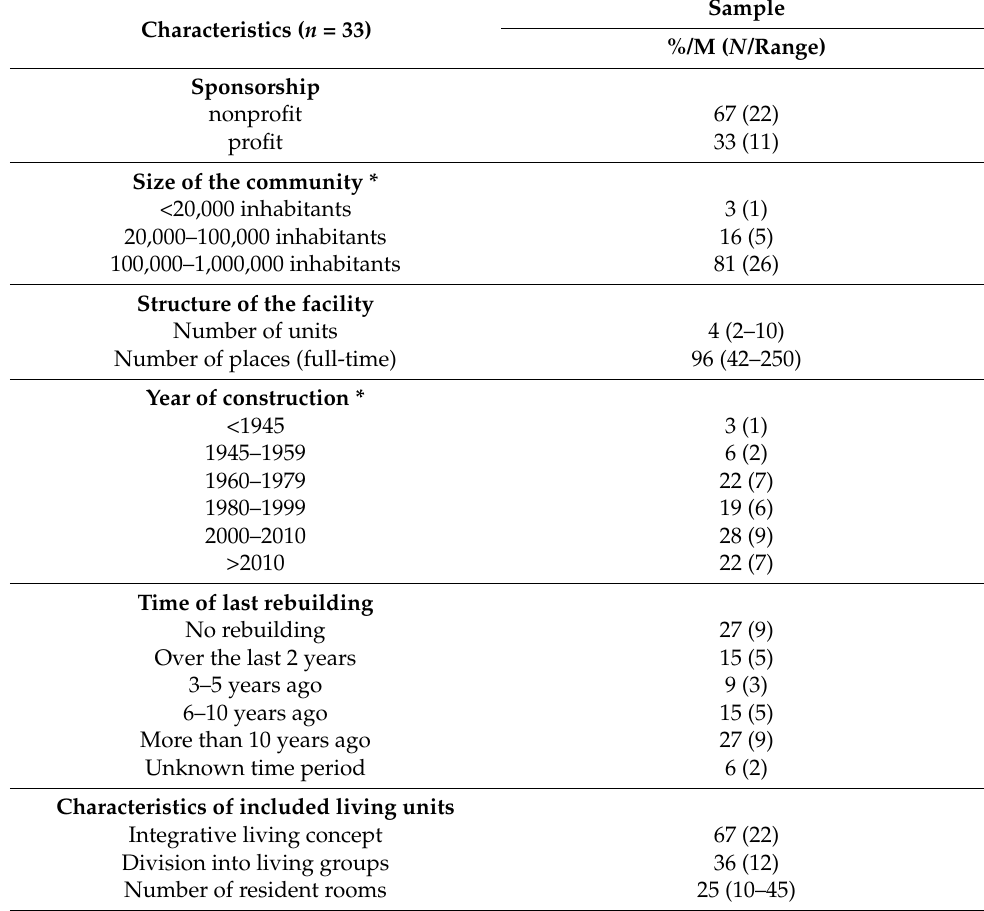
Table 1. Structural characteristics of the included living units in stage